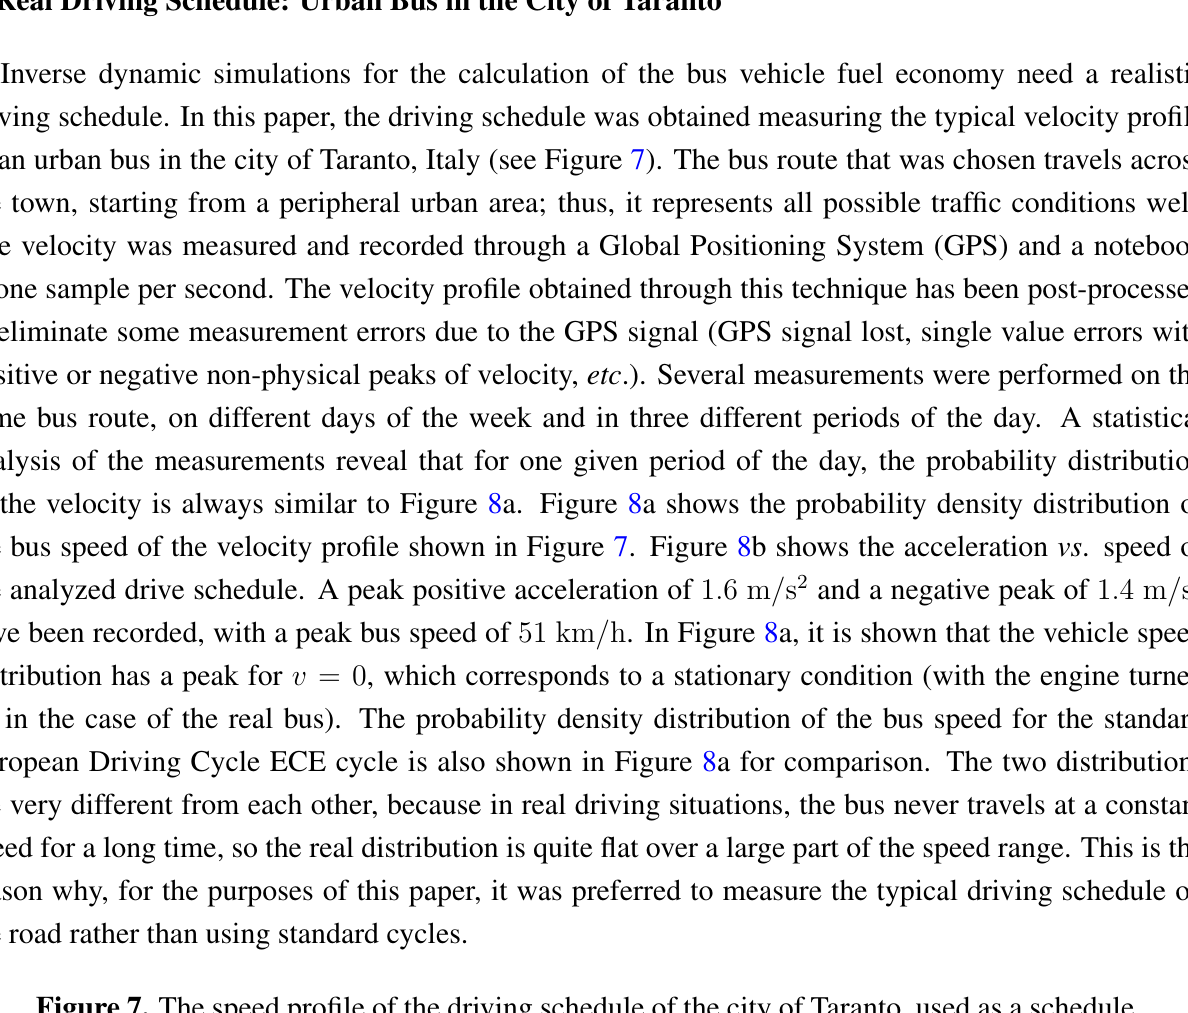
Figure 7. The speed profile of the driving schedule of the city of Taranto, used as a schedule in this